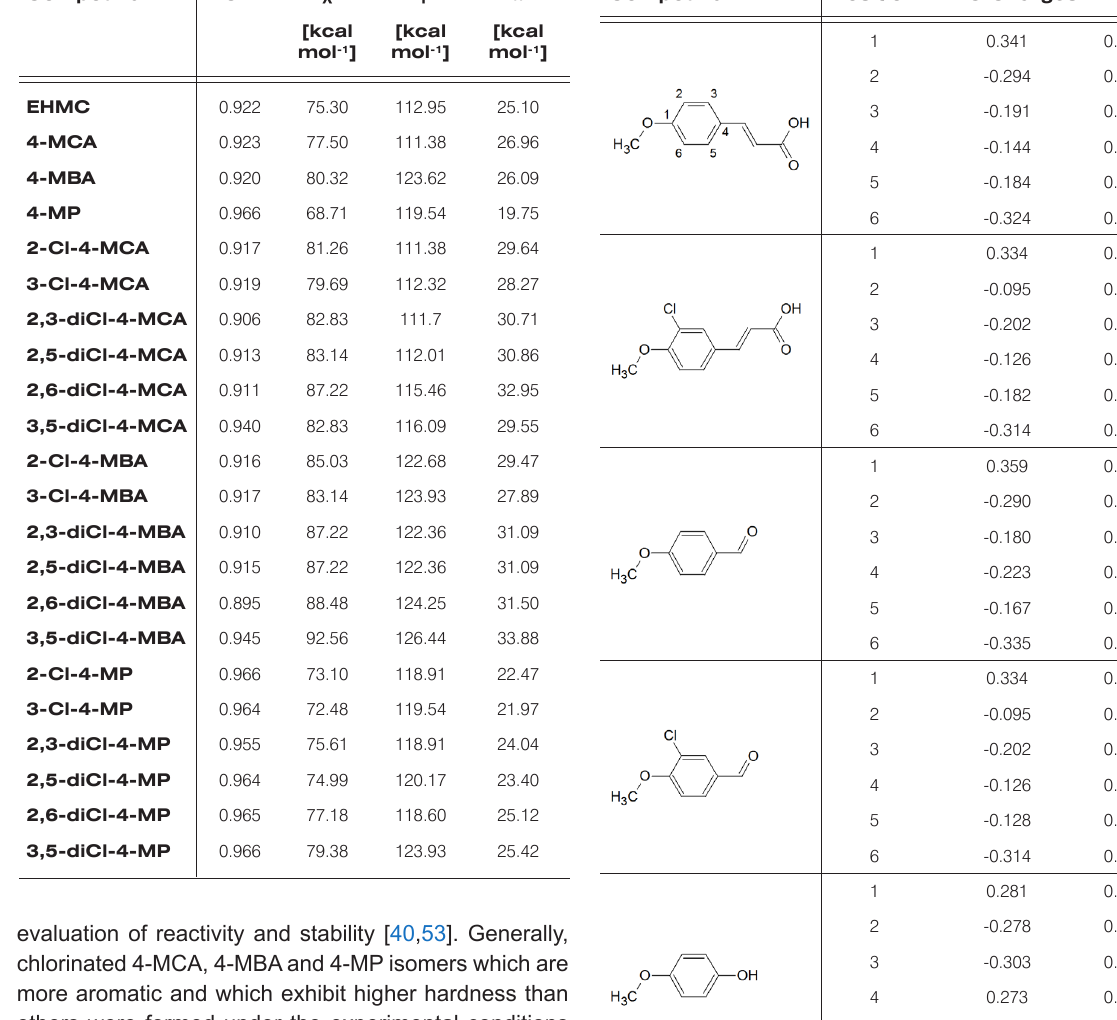
Table 4. Reactivity indices derived from HOMO and LUMO energy levels and benzene ring geometry. Compound